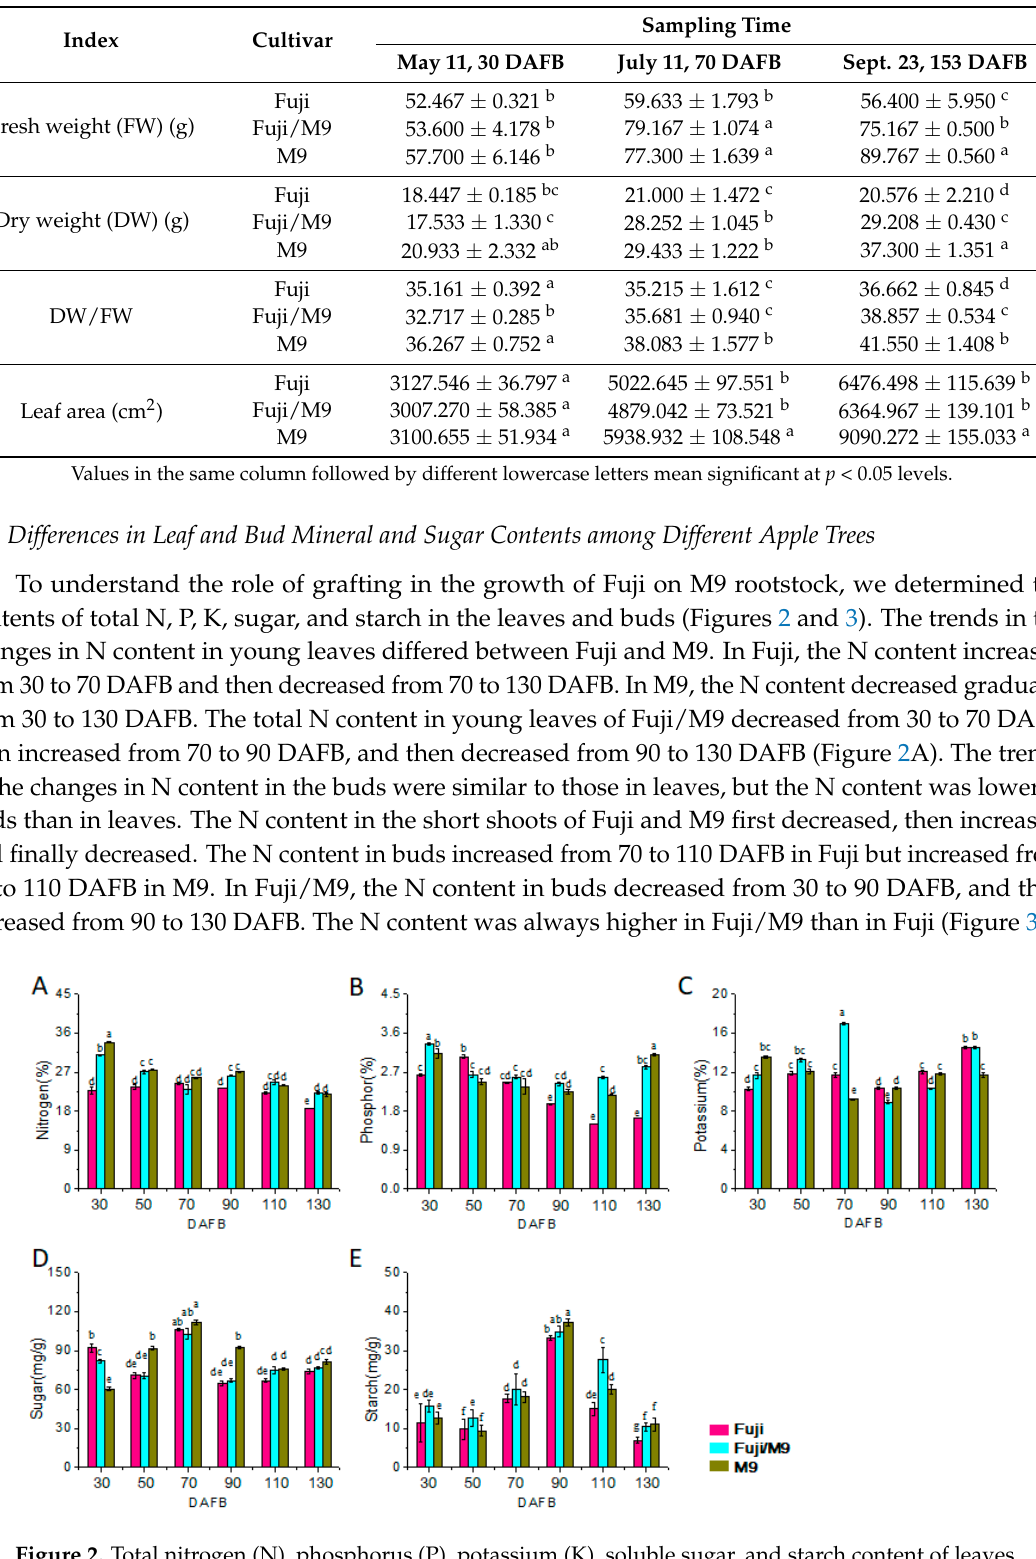
Figure 2. Total nitrogen (N), phosphorus (P), potassium (K), soluble sugar, and starch content of leaves in different apple trees: ( A ) total N content, ( B ) total P content, ( C ) total K content, ( D ) total soluble sugar content, and ( E ) starch content.